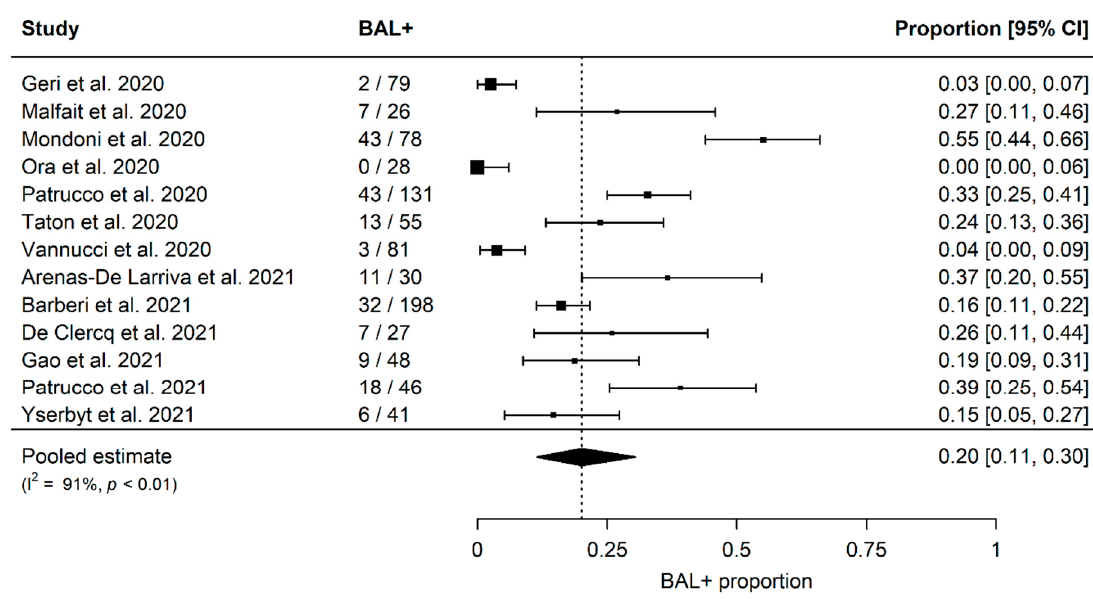
Figure 2. Overall proportion of SARS-CoV-2 positivity in BAL fluid [4–16].